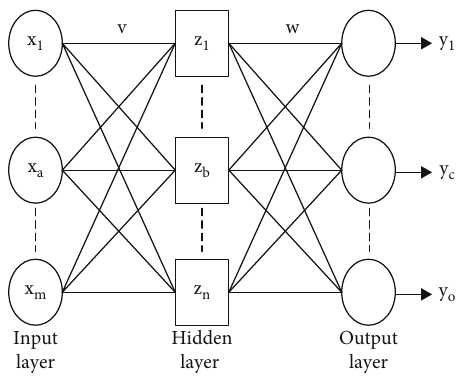
Figure 1: Structure and parameter of BP neural